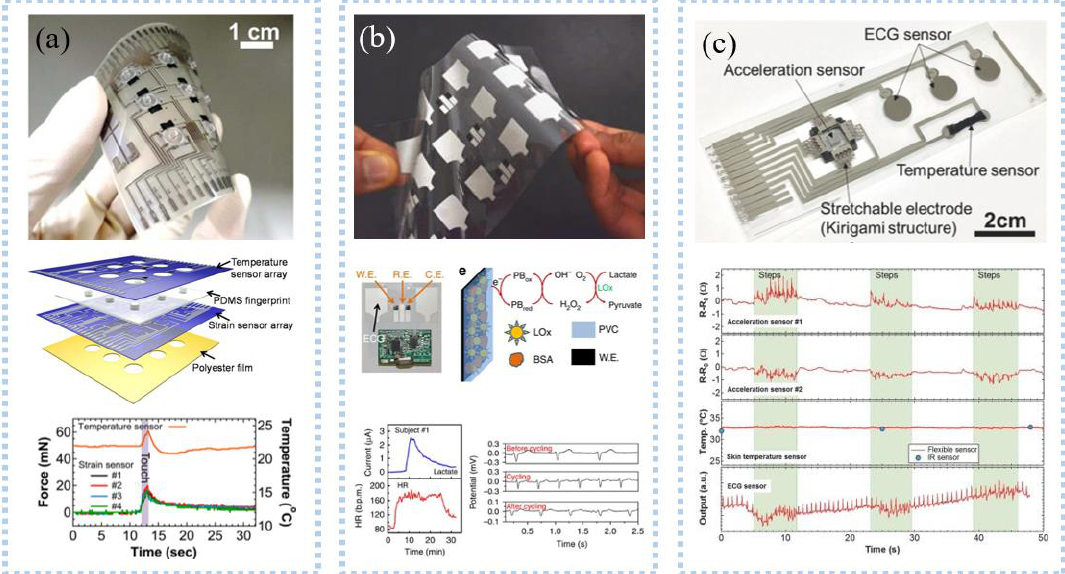
Figure 12. Multimode signal detection: ( a ) Picture of a 3 × 3 array e−skin (upper), schematic for each layer of the e−skin device (middle), results of real−time measurements of the temperature and strain sensors (lower). Reprinted with permission from Ref. [152]. Copyright 2014 John Wiley and Sons, ( b ) an array of printed Chem−Phys flexible patches (upper), image of a Chem– Phys patch along with the wireless electronics (middle), results of the real-time lactate concentration and the heart rate (lower). Reprinted with permission from Ref. [153]. Copyright 2016 Springer Nature, ( c ) a fabricated sensor sheet, showing the positions of the integrated sensors (upper) and real−time results for simultaneous measurement of human motion, skin temperature, and heart rate . Reprinted with permission from Ref. [155]. Copyright 2017 John Wiley and Sons.